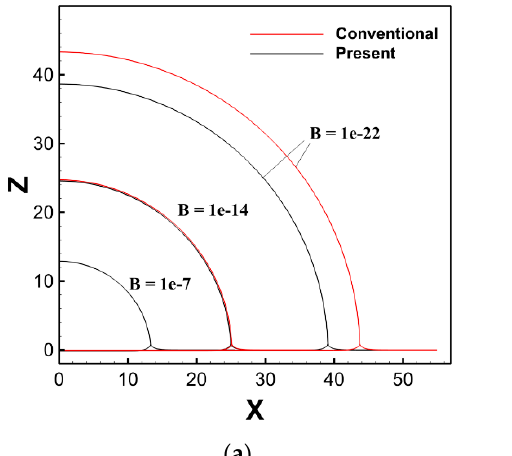
Figure 5. Comparison of the conventional (red) and the improved (black) methods for large bubbles. The tolerance of the ODE solver is set to 10 (cid:2879)(cid:2869)(cid:2870) . ( a ) Floating bubble shapes for the following three large bubble sizes: 𝐵 = 1E-7, 1E-14, and 1E-22. ( b ) The dimensionless cap radius 𝑅 (cid:2868) is plotted with respect to the parameter 𝐵 .